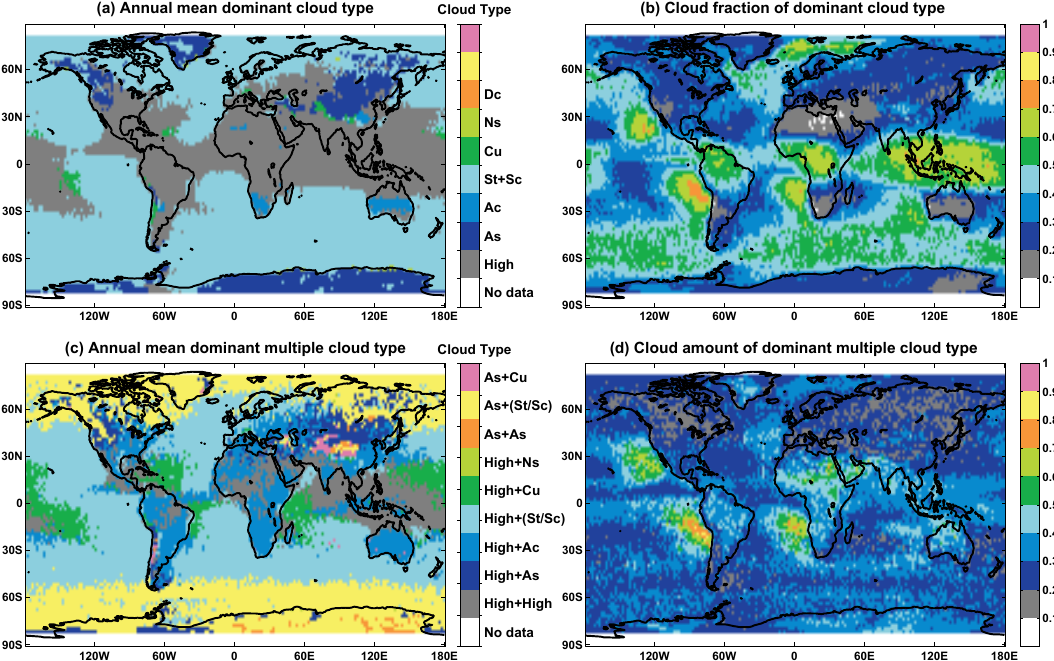
Figure 3. The global distributions of (a) the annual mean dominant cloud types and (b) the corresponding cloud fractions, and of (c) the annual mean dominant multiple cloud types and (d) the corresponding cloud amounts.